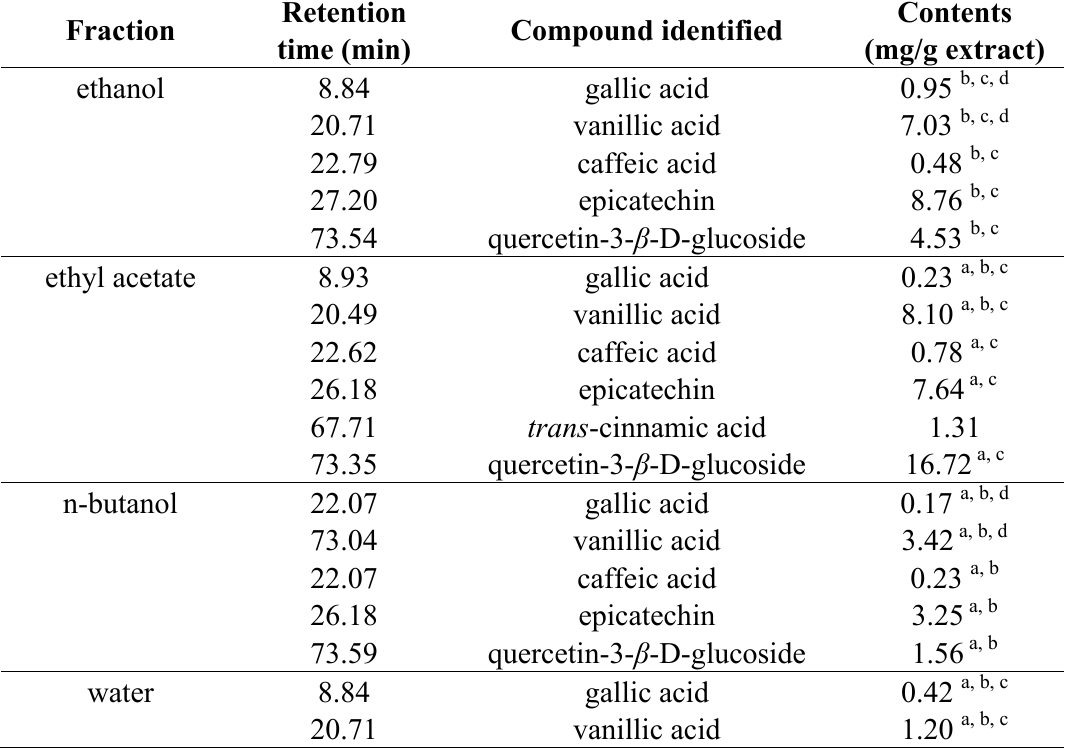
of main polyphenolic compounds of ethanol extract and soluble fractions from Leptadenia pyrotechnica